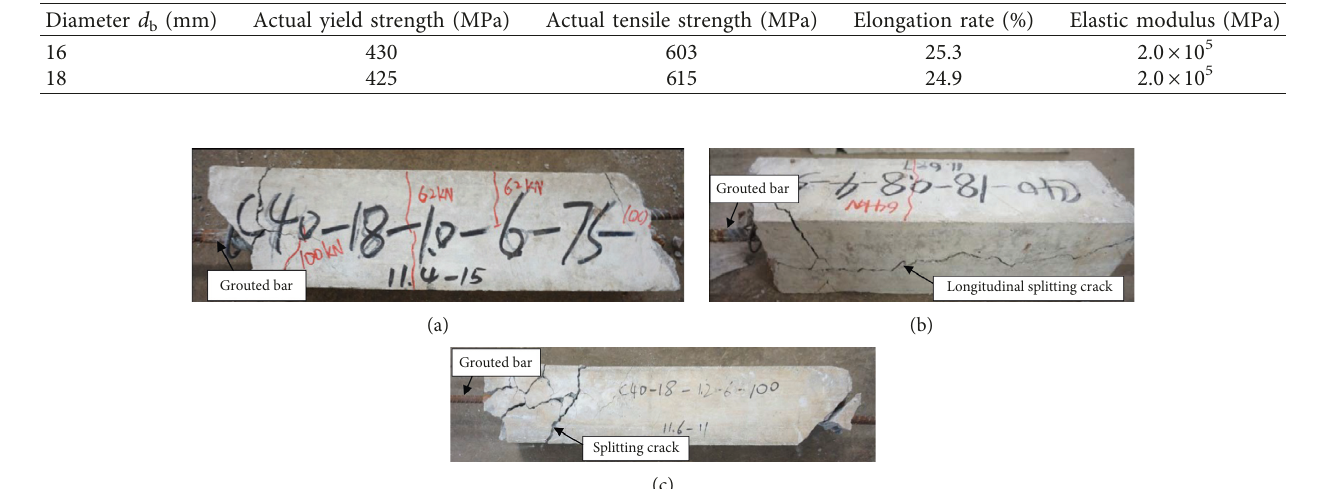
Table 1: Properties of reinforcing steel bars (average value of three specimens).